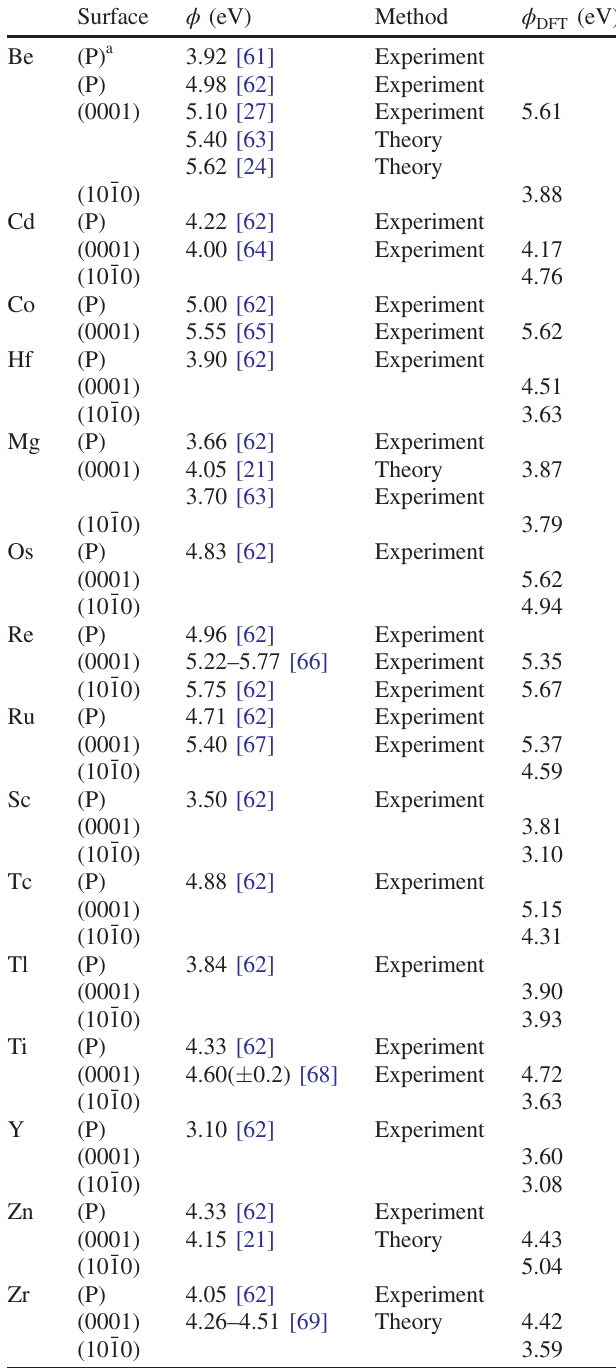
TABLE II. Work functions of the 15 hcp metals.